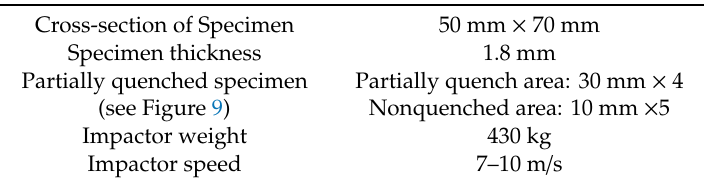
Table 3. Conditions of axial crash